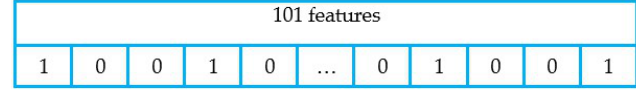
Table 3. The optimal parameter settings of the algorithms.